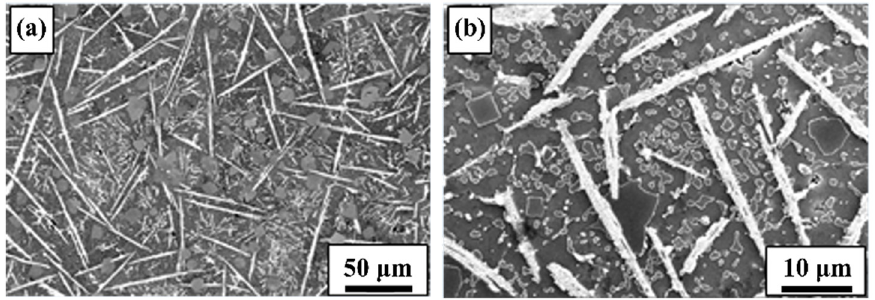
Figure 3. Scanning electron microscopy images of the SLM fabricated Al-20Si-5Fe-3Cu-1Mg alloy with substrate plate heating to 673 K: ( a ) low magnification image and ( b ) high magnification im-